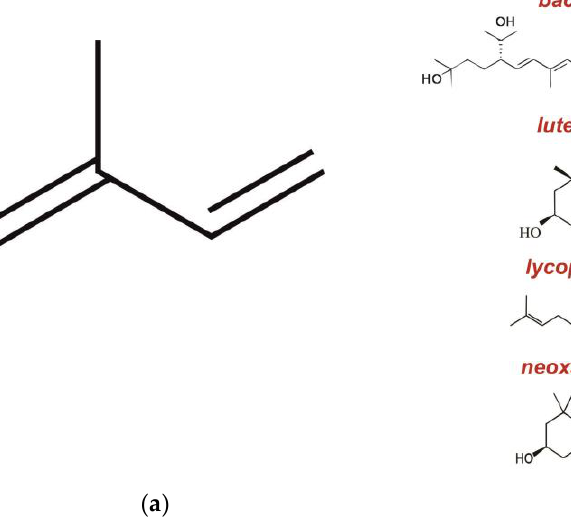
Figure 4. Structures and spectra of different carotenoids: ( a ) Isoprene unit; ( b ) Structures of different carotenoids. Adapted from [78].